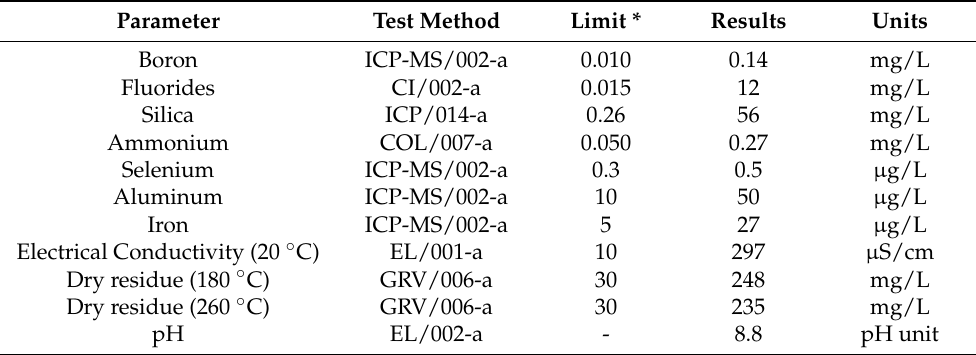
Table 2. Results of the laboratory measurements carried out on the waters of the